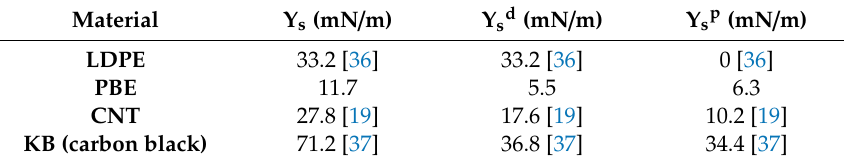
Table 7. Surface tensions (mN / m) of LDPE, PBE, CNT and KB at room temperature.